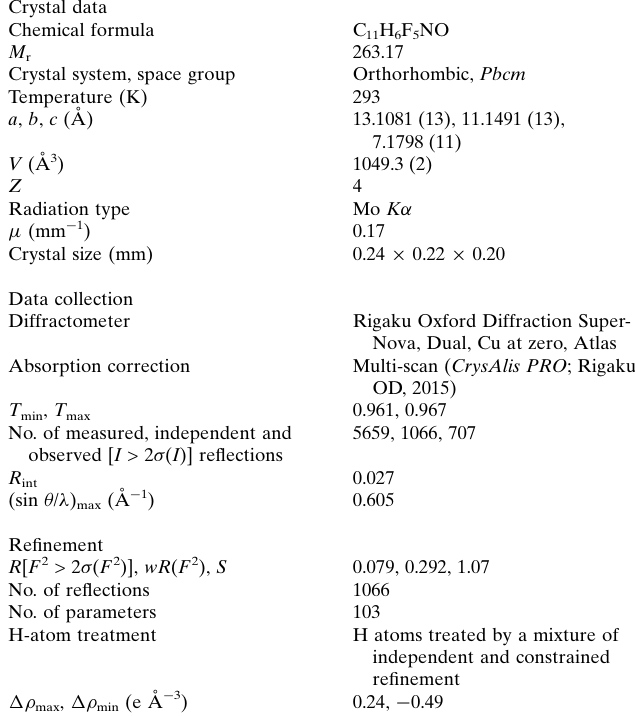
Table 2 Experimental details.